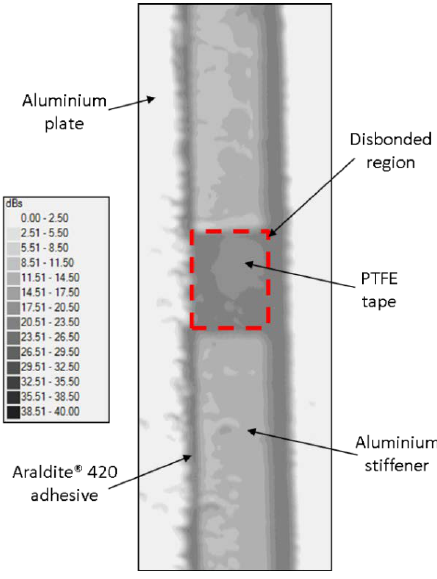
Figure 12. C-Scan results of the panel with the disbonded region. Note the region with the induced disbond containing what appears to be remnants of PTFE tape.